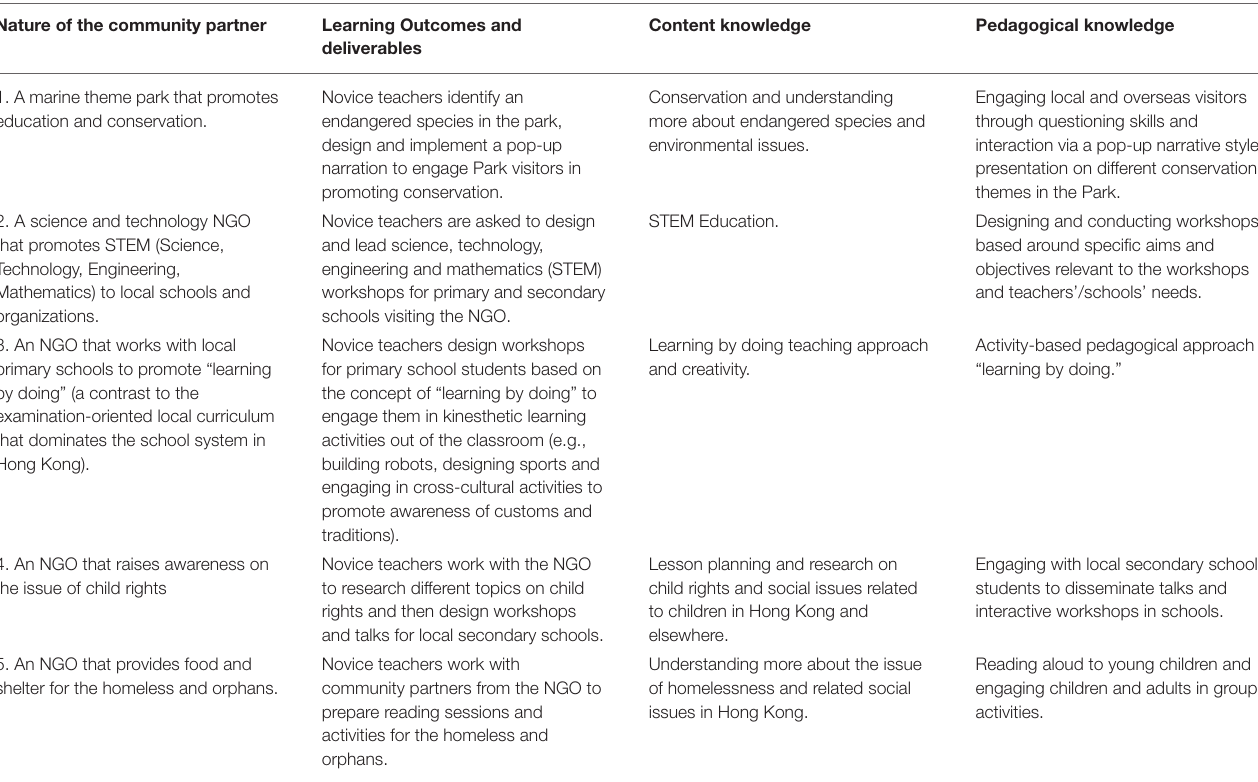
TABLE 1 | Examples of community-based projects taken by novice